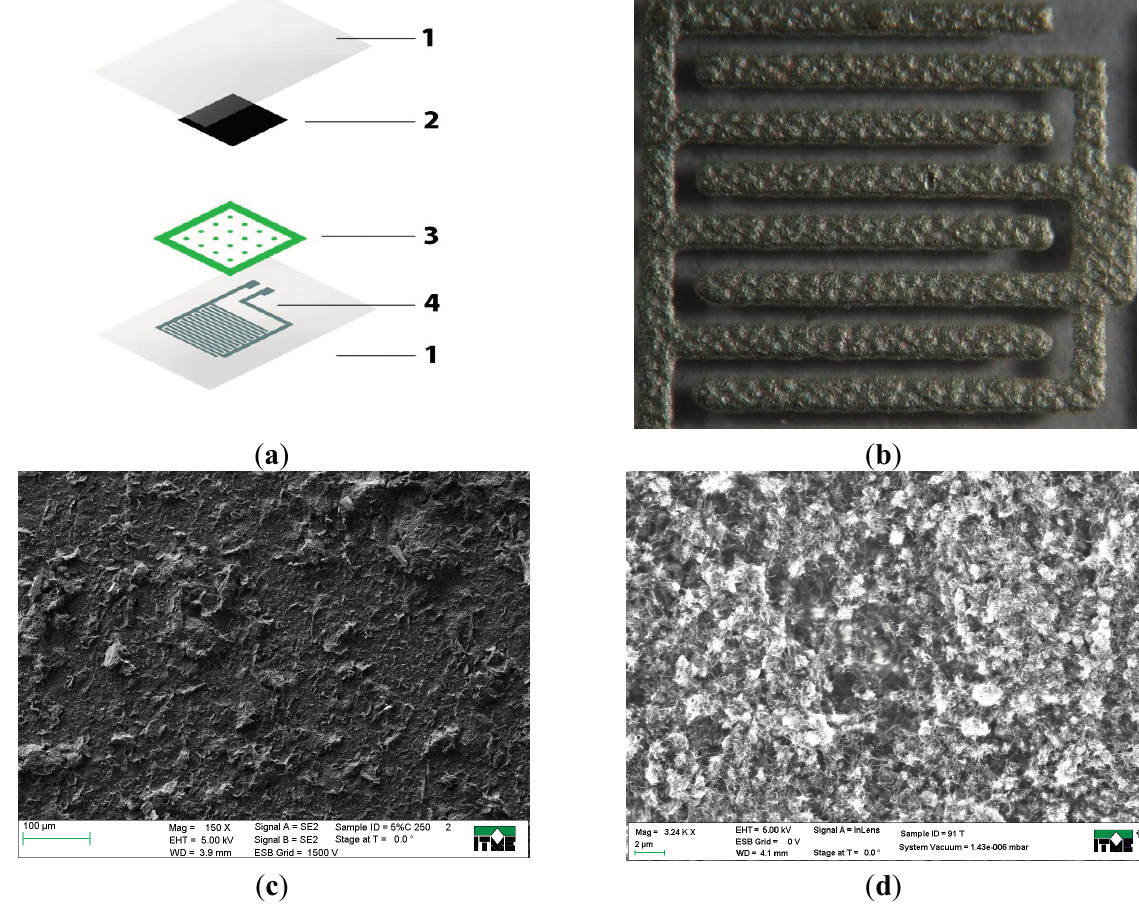
Figure 2. ( a ) Screen printed resistive pressure sensors: 1—polyester substrate, 2—pressure sensitive layers, 3—dielectric separator, 4—silver electrode. ( b ) comb